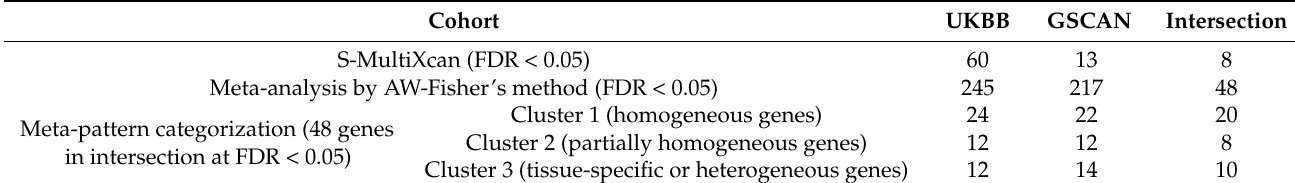
Table 1. Summary of the number of cigarettes per day (CPD)-associated genes detected by meta- analysis and S-MultiXcan as well as in each category of unique meta-pattern in both UK Biobank